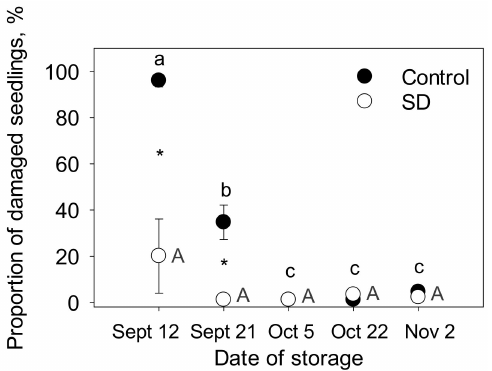
Figure 6. Proportion of damaged Norway spruce seedlings after the first growing season (2013) in the field. 1.5 year old seedlings were grown either under a natural photoperiod (control) or exposed to a short-day (SD) treatment in late summer 2012 (mean ± SE, n = 6 blocks). The data were subjected to a generalized linear mixed model. Di ff erences between the storage dates within the control treatment are indicated by small letters, and within the SD treatment by capital letters ( p < 0.05). Asterisks indicate di ff erences between the treatments within each storage